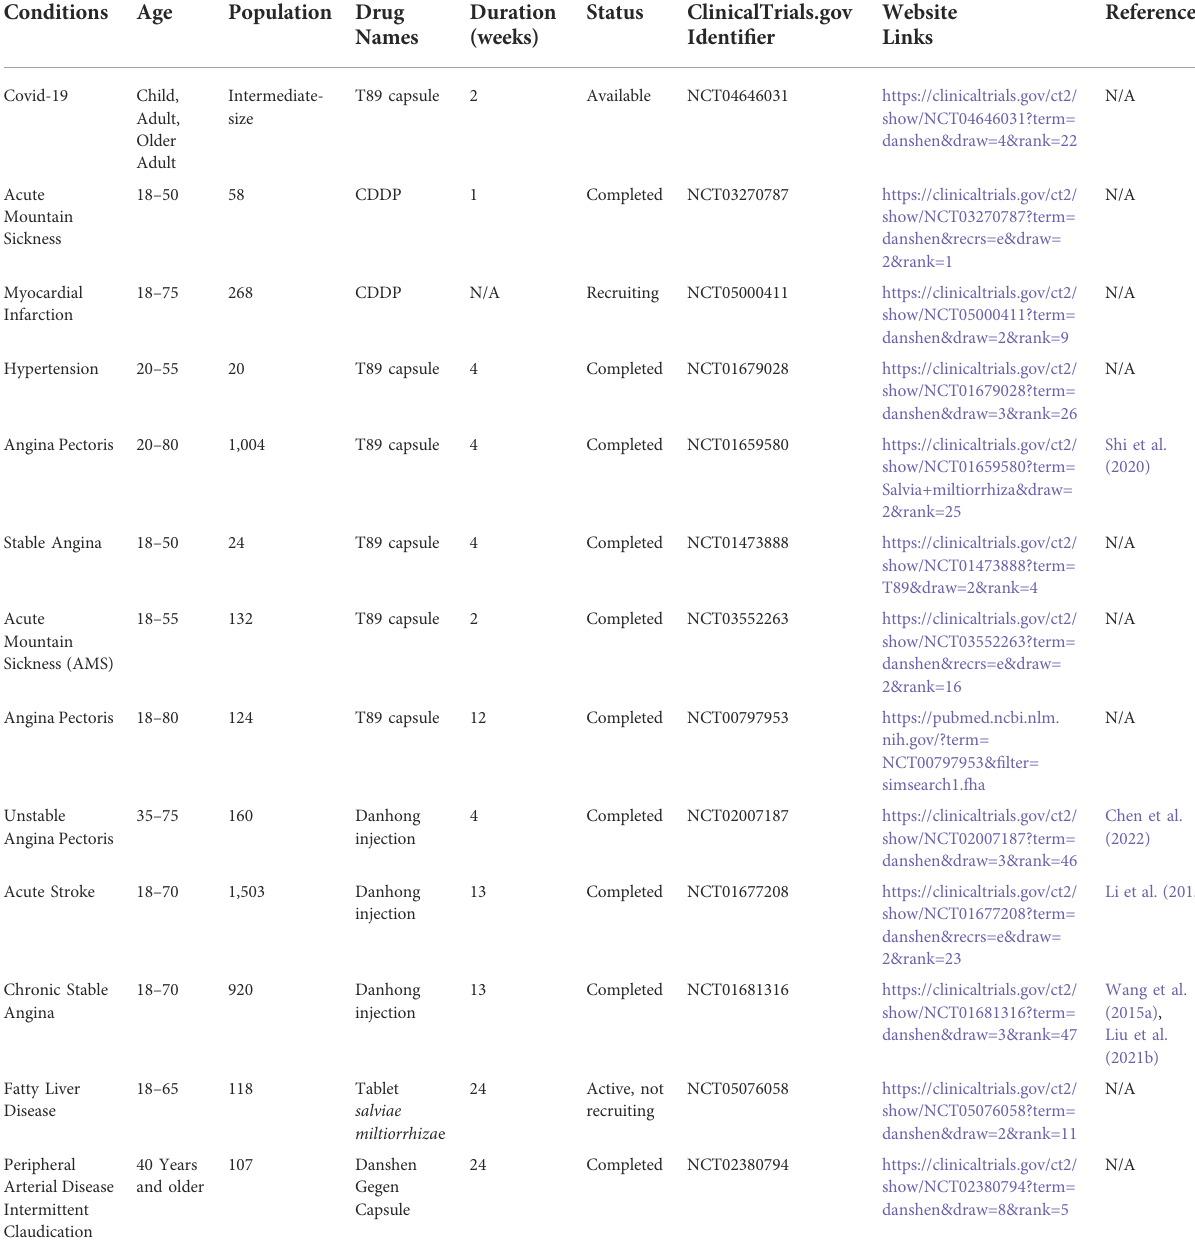
TABLE 1 Clinical trials of compound medicines containing CTS in various diseases